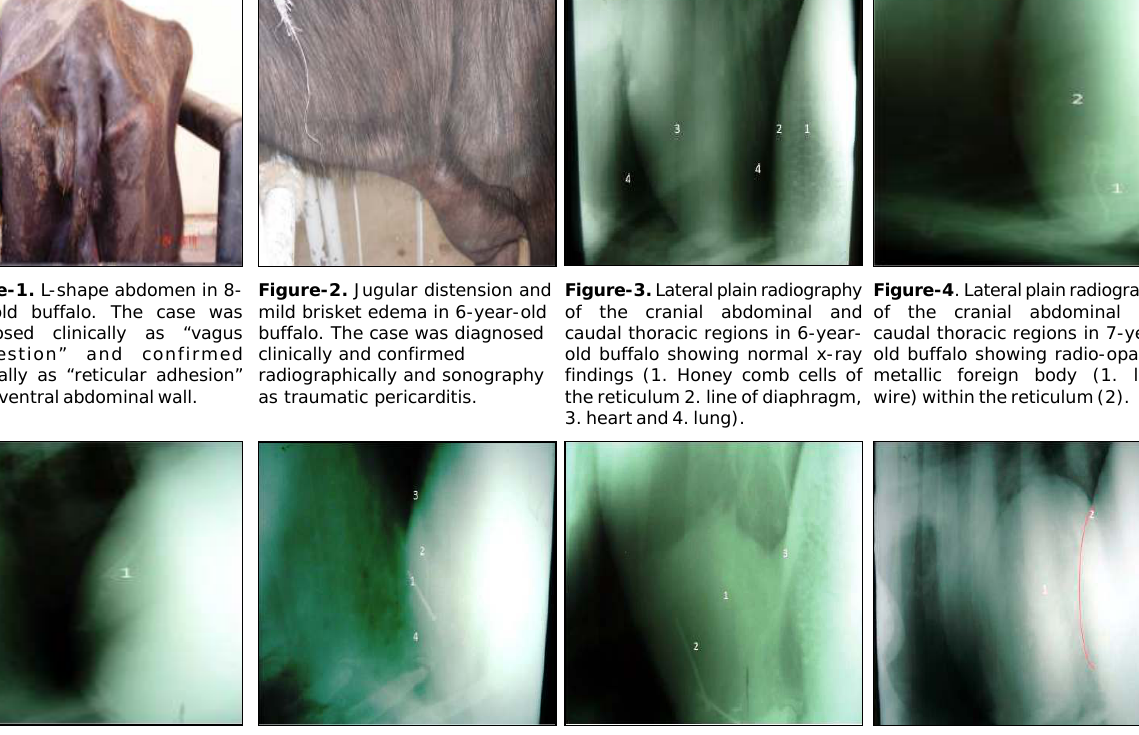
Figure-7. Lateral plain radiography of the cranial abdominal and caudal thoracic regions in 4-year- old buffalo showing circumscribed swelling of soft tissue density- reticulum (1) containing radio dense metallic foreign body (2) within the thorax and overlying the ventral border of the heart with discontinuation of the diaphragm (3). The case was diagnosed clinically as SFBS and confirmed radiographically as diaphragmatic hernia